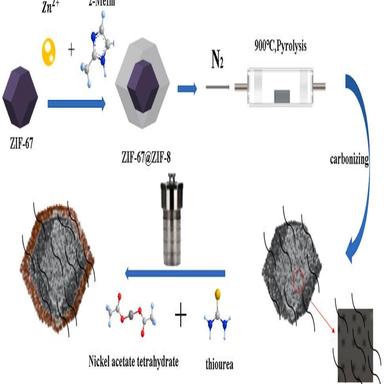
XRD patterns of simulated ZIF-67 and synthesized ZIF-67, ZIF-8, ZIF-67 @ZIF-8 (a) and Co-NC, NiS, NiS@Co-NC (b).